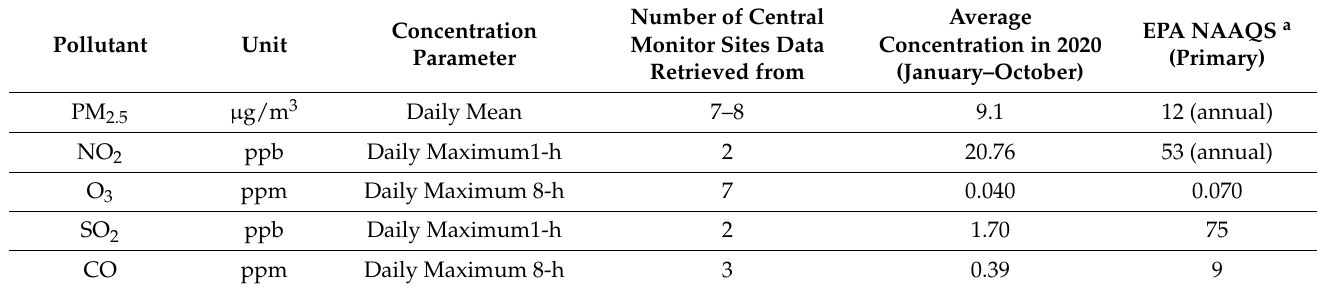
Table 1. Air pollutants, number of monitoring stations and related metrics used in the study.